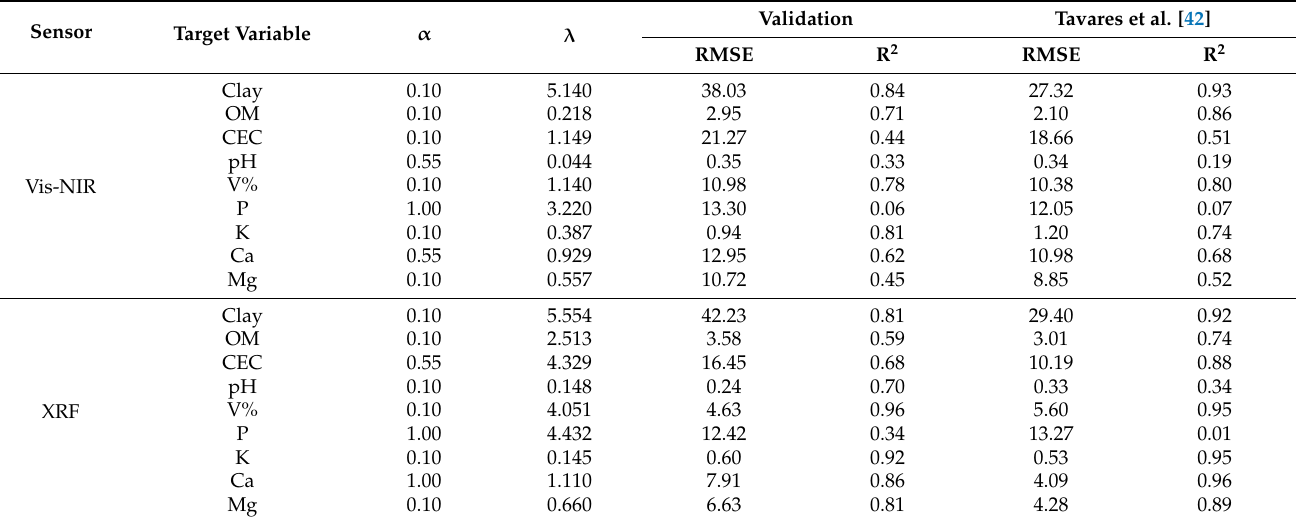
Table 2. Results from least absolute shrinkage and selection operator (lasso) regression fitting models applied to the soil physical-chemical attributes